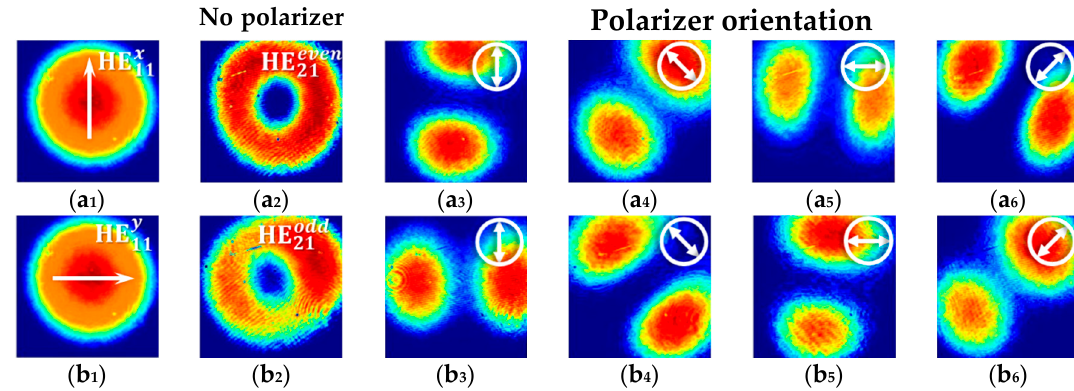
HE x and HE y modes taken by an charge coupled device ( CCD) in of HE y and modes taken by an charge coupled device (CCD) in absence 11 11 11 11 and HE odd modes taken by a CCD in absence of a polarizer; HE even and HE odd modes taken by a CCD in absence of a 21 21 21 21 and HE odd modes in presence of polarizer at different polarization HE even and HE odd modes in presence of polarizer at different 21 21 21 21